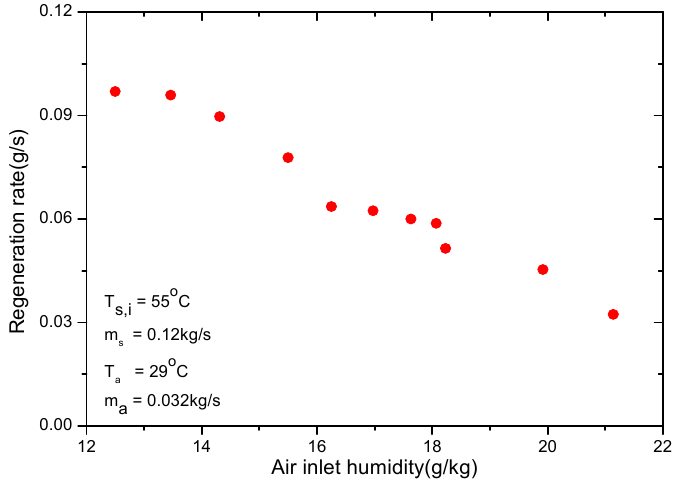
Figure 5. Influence of air humidity on